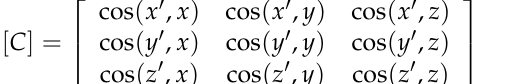
Figure 4. The relationship between the global coordinate system and the local coordinate system of the joint plane.